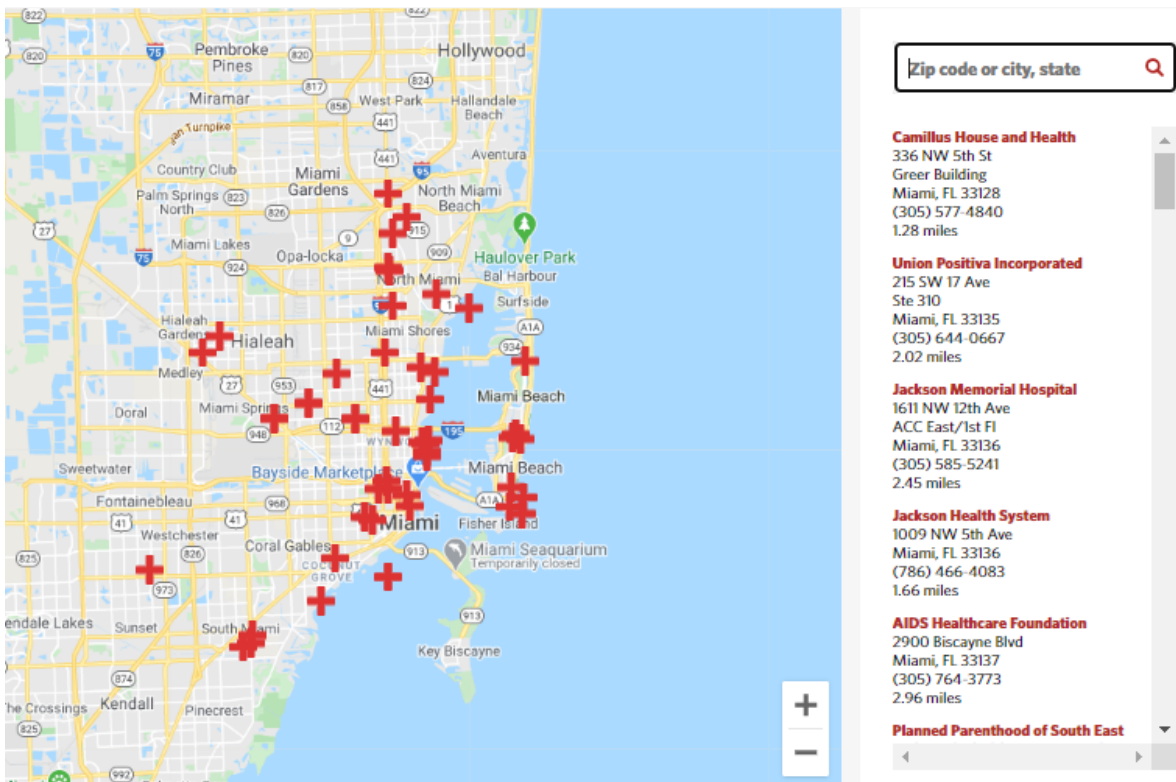
Figure 5. Example of HIV testing service locator for Miami Dade